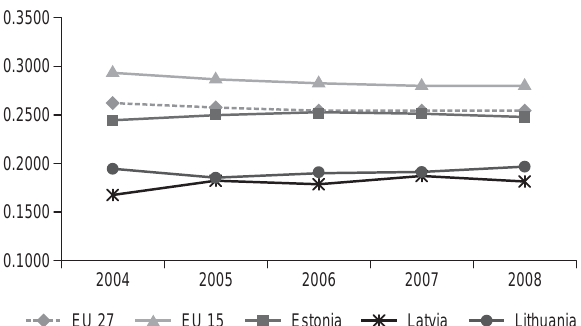
Fig. 4 . Dynamics of aggregated assessment of Baltic countries in the EU context during the period of 2004–2008 (the second situation). Data source: Eurostat, Transparency international, The Heritage Foundation, computed by authors